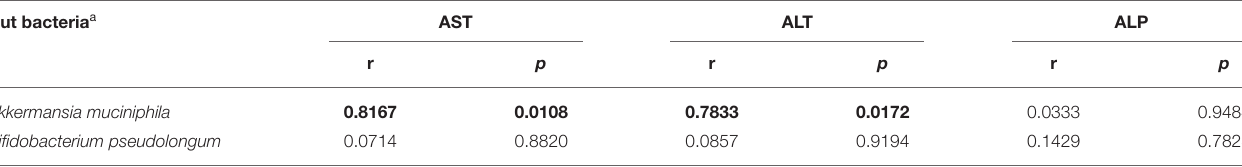
TABLE 1 | Spearman’s correlation of gut microbiota and indices of liver function. Gut bacteria